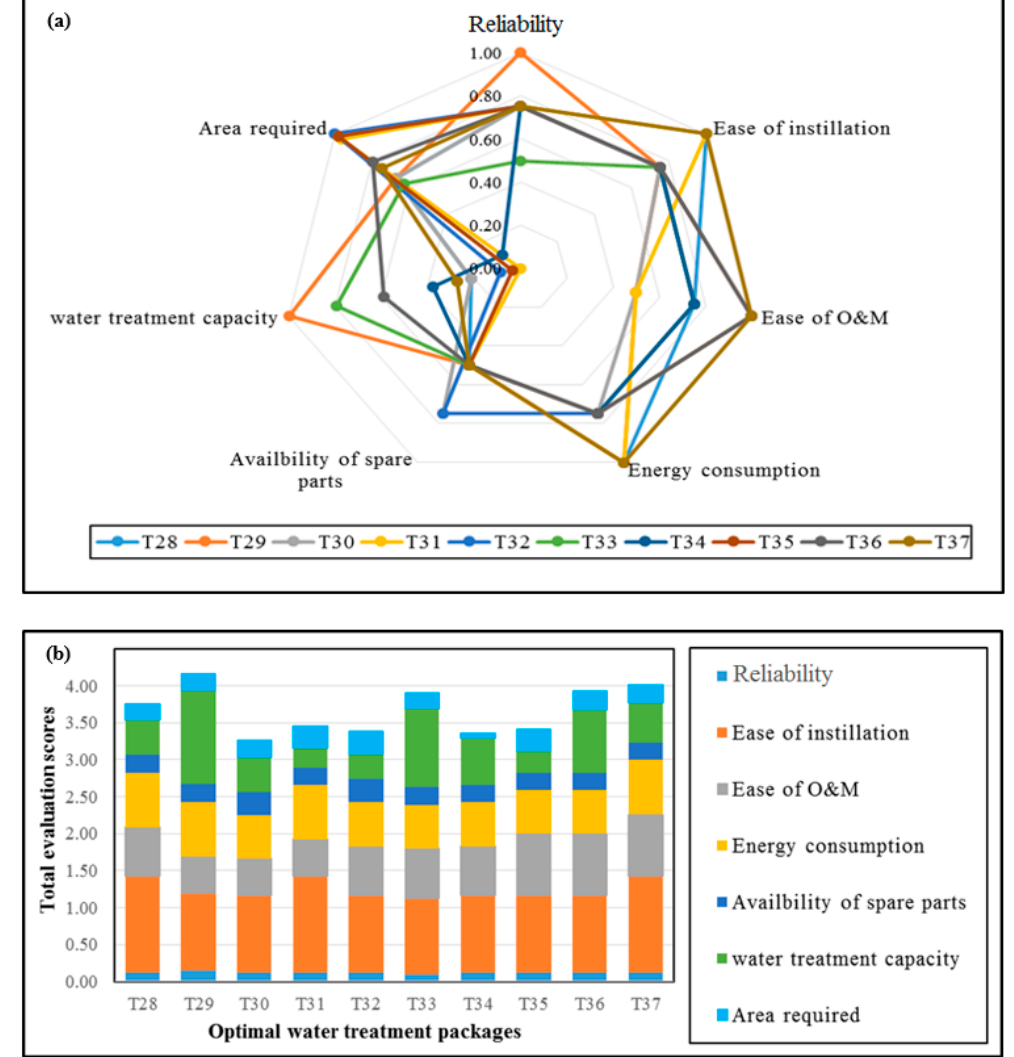
Figure 4. Results of Scenario 3—packaged drinking water treatment systems for an emergency situation: ( a ) Criteria / objective contribution star chart; ( b ) Stacked column on performance of water treatment systems.